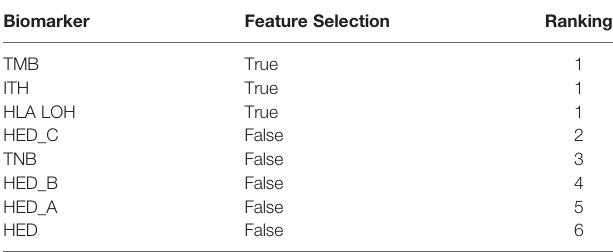
TABLE 1 | List of the optimal combination from eight features.